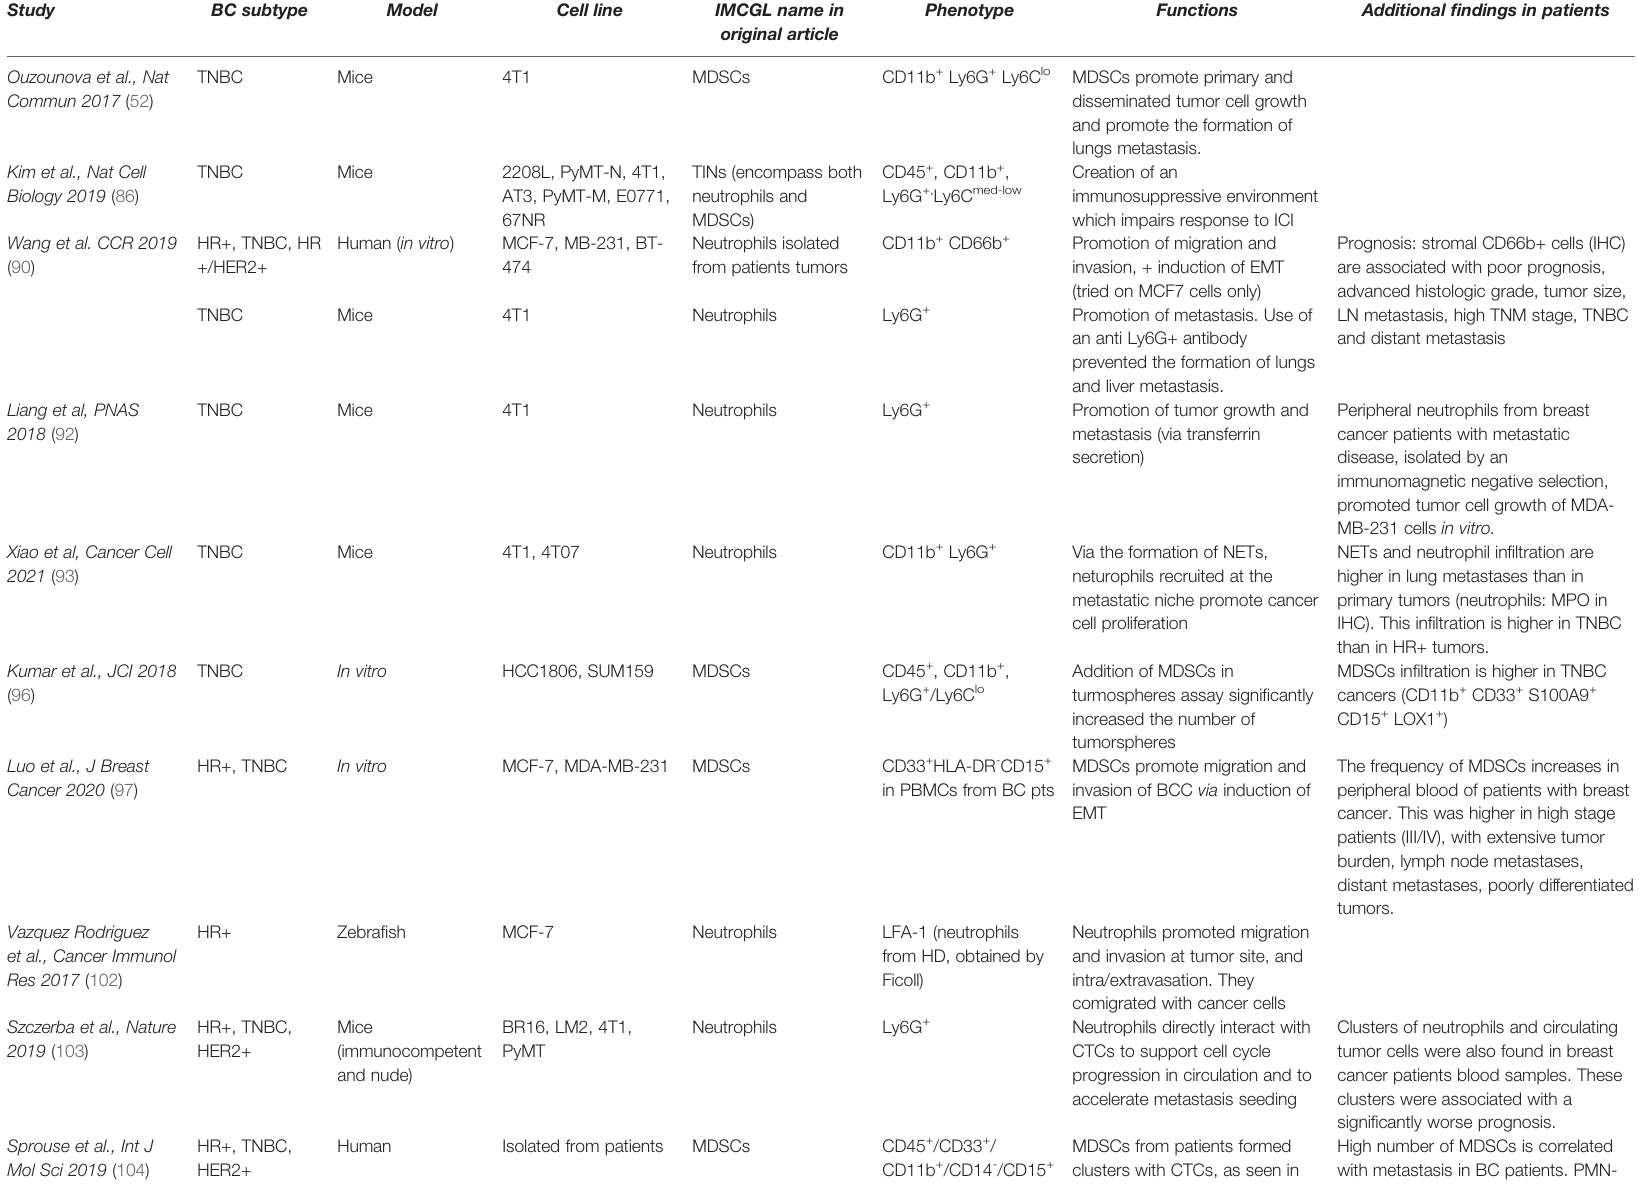
TABLE 1 | IMCGL terminology, phenotype and non-immunological